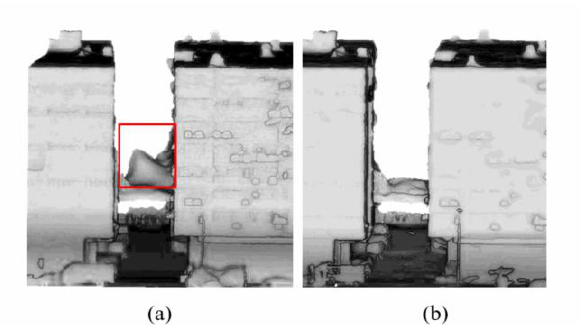
Figure 4. Illustration of point cloud filtering. (a) Mesh model generated without point cloud filtering. (b) Mesh model generated after point cloud filtering, of which the problematic area indicated by the red box in (a) has been